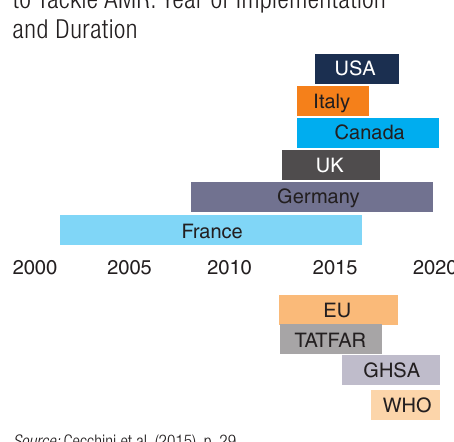
FIGURE 10. National and International